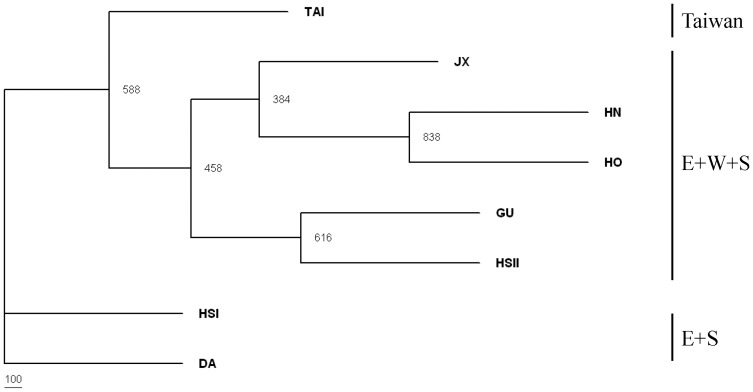
Unrooted NJ tree showing genetic relationship based on microsatellite loci among populations.Numbers at the nodes are bootstrapping values from 1000 replicates.